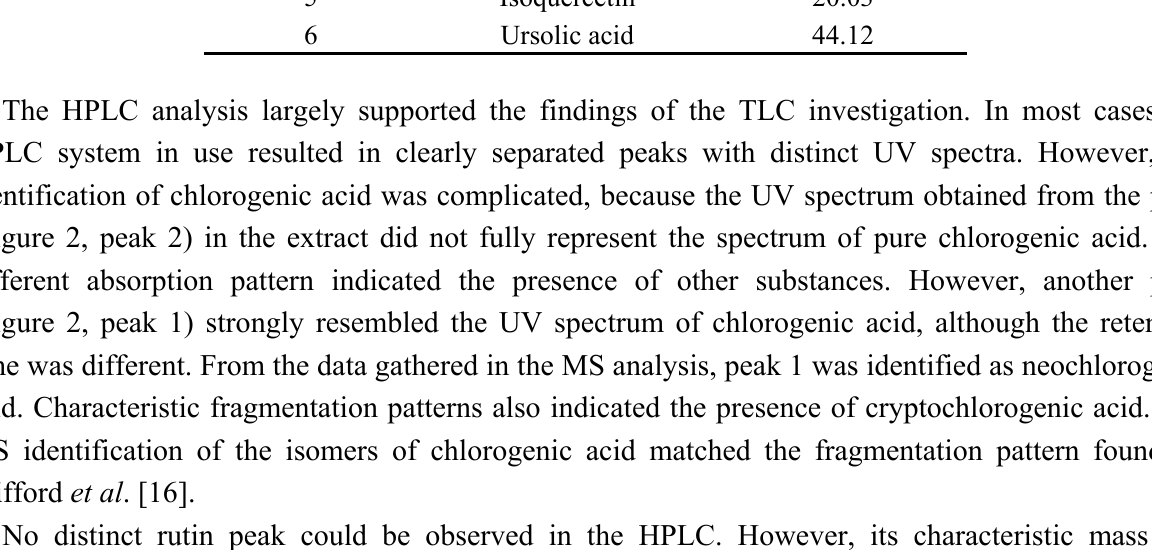
Table 3. Identified compounds and their retention time ( R Peak